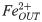
DMT1 phenomenological state-model.The model consists of a four state-cyclic representation of DMT1 kinetic mechanism. Empty DMT1 (P1) is oriented to the apical side where it can bind to Fe2+ (P2), then suffers a conformational change (P3), releases iron to the intracellular media (P4) and returns to its original state (P1). (orange circle): apical iron concentration (FeOUT2+); (brown circle): iron concentration in the intracellular-basolateral space (FeIN2+).